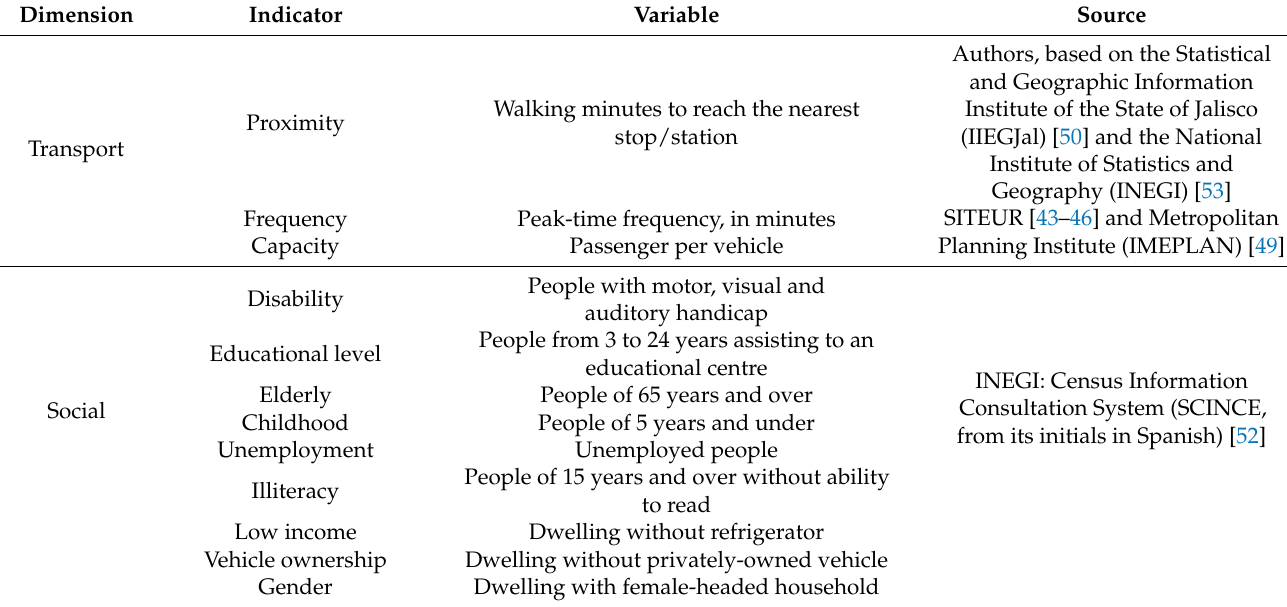
Table 2. Factors, Indicators, and Data Sources Used to Assess the Index of Mass Transport Provision and the Index of Transport Social Needs.